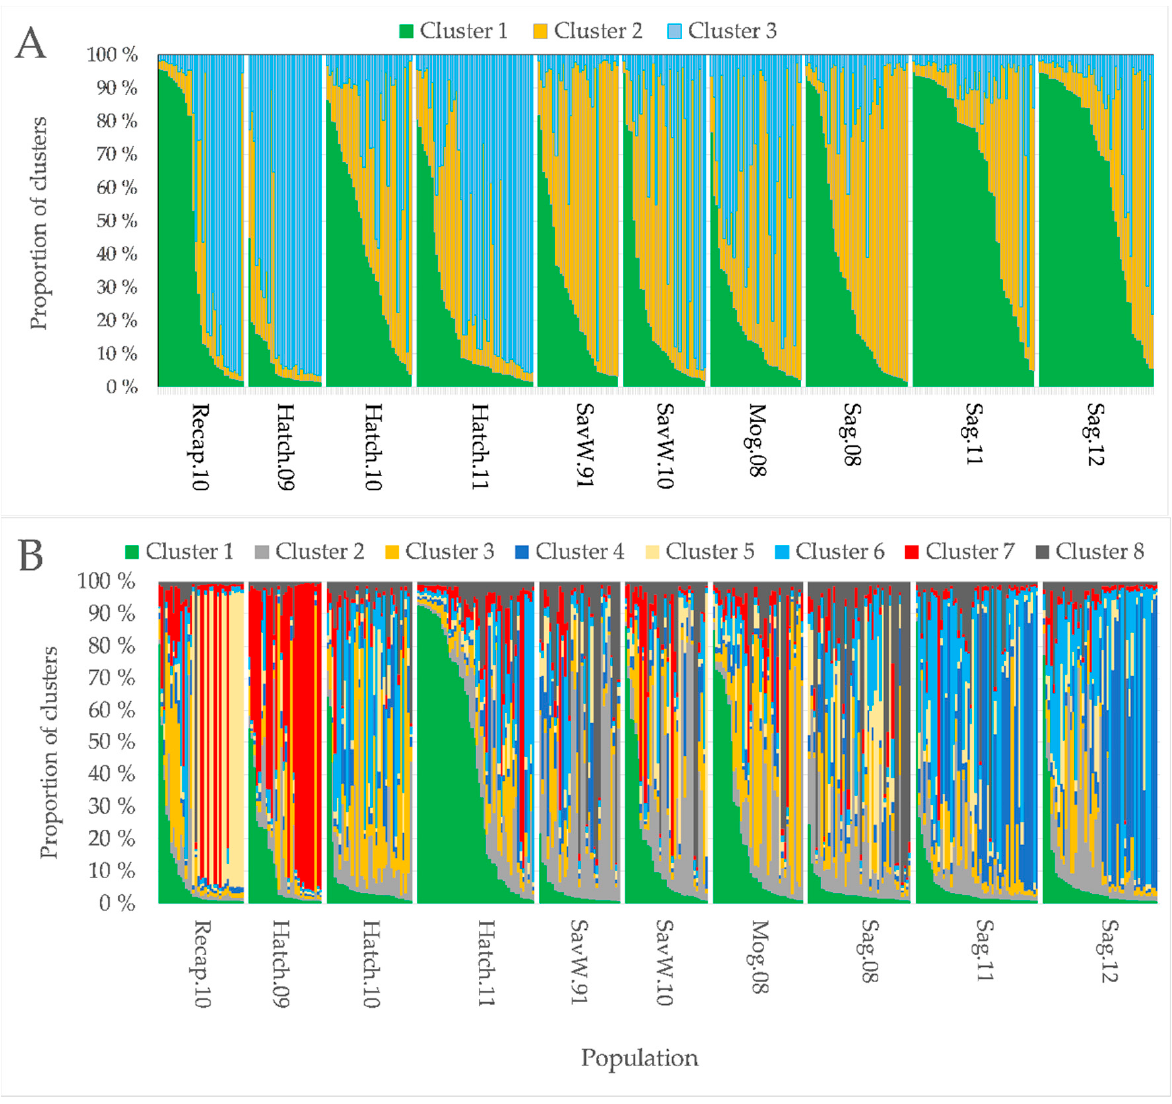
Figure 4. Summary plot of the estimated individual membership coefficients of each cluster 1–3 (( A ), K = 3) and cluster 1–8 (( B ), K = 8). Each specimen is represented by a single vertical line broken into segments, with lengths proportional to each of the K -inferred clusters, sorted in decaying membership of Cluster 1.